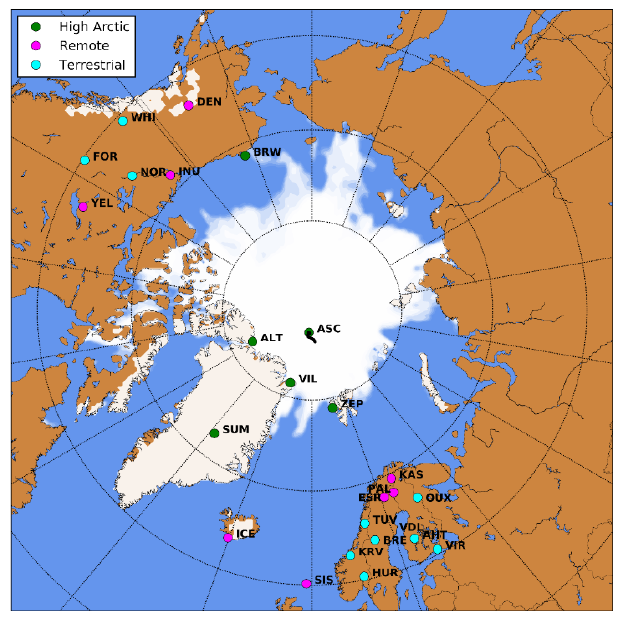
Figure 1. WRF domain including sea ice and snow cover at the start of the simulation. Locations with surface observations O 3 are indicated in green (High Arctic), magenta (Remote) and cyan (Ter- restrial) (see Sect. 2.5). The drifting path of the ASCOS campaign during the simulation is indicated with the black